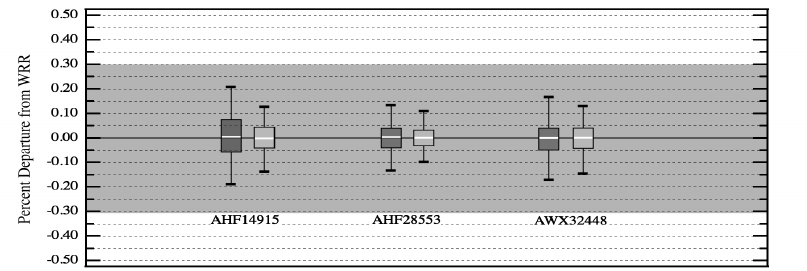
Figure 3. Results for three North American Region cavity type pyrheliometers. Darker shaded box plot data: IPC-XII 2015. Lighter shaded box plot data: NPC-2018. The shaded band across the graph is the historical assigned uncertainty of the WRR. Box and whisker information is the same as in Figures 1 and